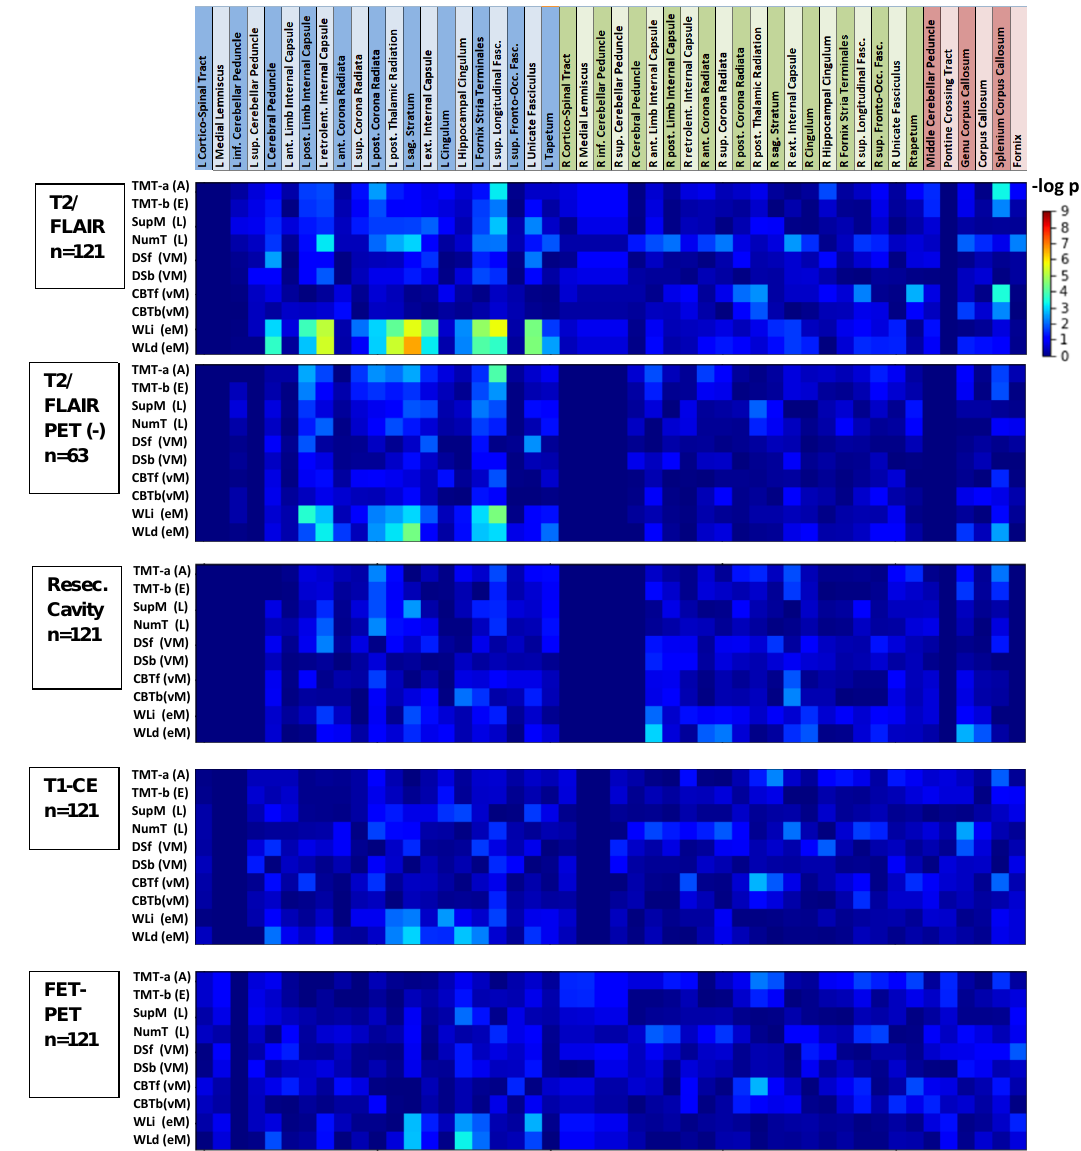
Figure 4. Heatmap of the correlation analysis between the volumetric overlap of four types of lesions with atlas-based white matter tracts [19] and the scores of 10 cognitive tests in n = 121 WHO Grade III/IV glioma patients. The tracts are ordered by location in the left and right hemispheres or midline structures. p -values are given for the Kendall-tau-b rank correlations. T2/FLAIR: lesions semi-automatically segmented in T2-weighted and FLAIR MR images; T2/FLAIR PET (-): p -values for a group of n = 63 patients with an absence of FET-PET-positive tumor growth; Cavity: manually segmented resection cavity; T1-CE: semi-automatically segmented contrast-enhancing regions in T1-weighted MR images; FET-PET: semi-automatically segmented FET-PET-positive lesions; TMT-a (A): trail-making—Test A (attention), TMT-b (E): trail-making—Test B (executive function); SupM (L): supermarket test (language); NumT (L): number transcoding (language); DSf (VM): digit span forward (verbal working memory); DSb (VM): digit span backward (verbal working memory); CBTf (vM): Corsi block tapping forward (visual working memory); CBTb (vM): Corsi block tapping backwards (visual working memory); WLi (eM): word list immediate recall (verbal episodic memory); WLd (eM): word list delayed recall (verbal episodic memory). No significant correlations were observed for the TMT-b/TMT-a